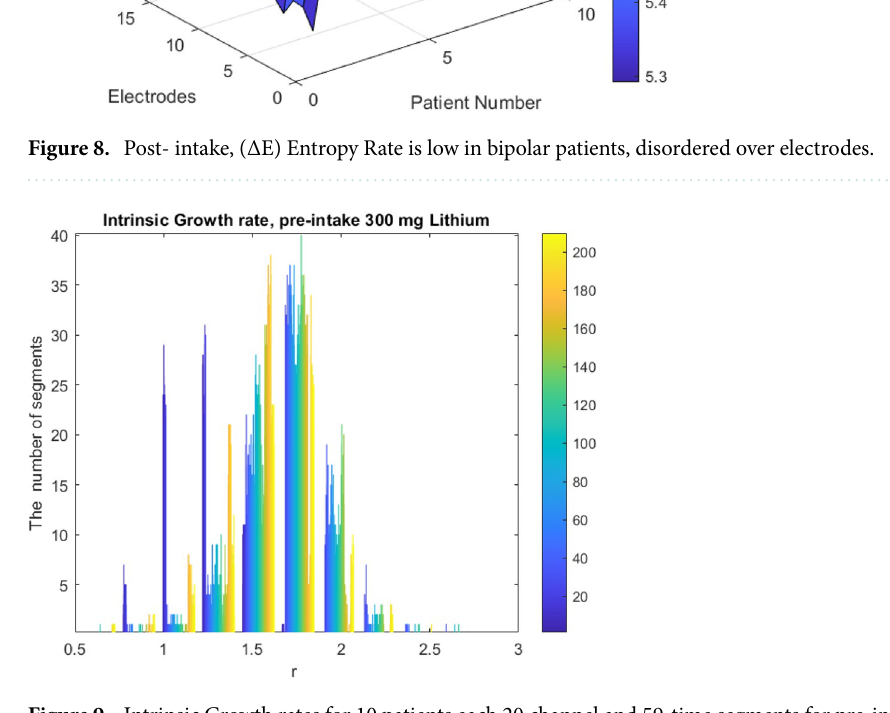
Figure 9. Intrinsic Growth rates for 10 patients each 20 channel and 59-time segments for pre-intake (6018-period doubling chaotic